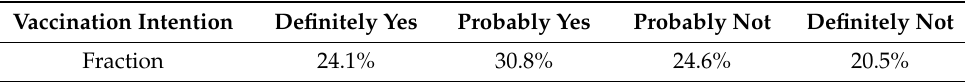
Table 3. Distribution of willingness to get